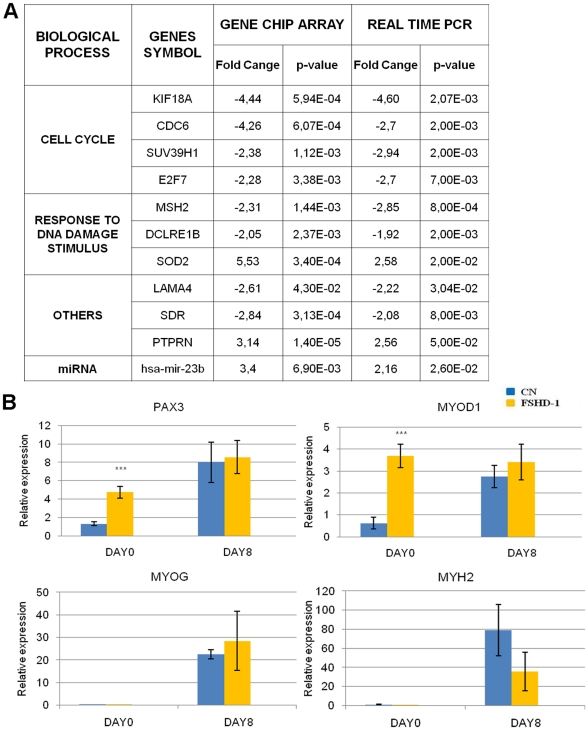
Real-Time PCR validation of FSHD-1 microarray data.A: Table reports the genes analyzed in qRT-PCR with fold-change and p-value. The data obtained in the FSHD-1 myoblasts gene chip array and the biological processes identified by the DAVID program, are also reported. The analysis was performed on seven FSHD-1 and six CN myoblast cell lines. B) Bar diagrams show relative expression of PAX3, MYOD1, MYOG and MYH2 in control and FSHD-1 myoblasts (day 0) and myotubes (day 8) relative to GAPDH. *** p-value < ,001.